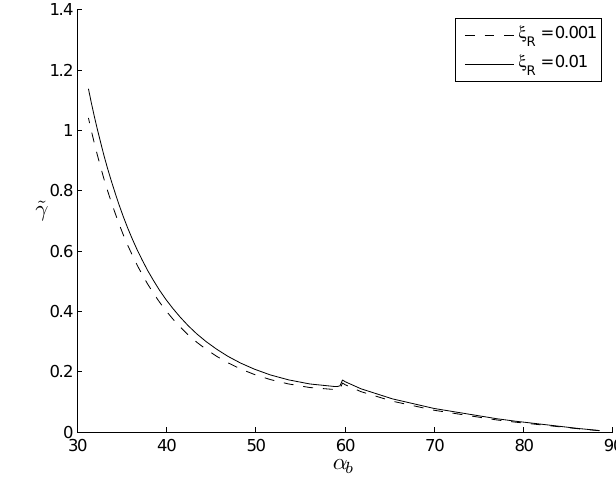
Fig. 4. Dimensionless growth rate versus angle α b